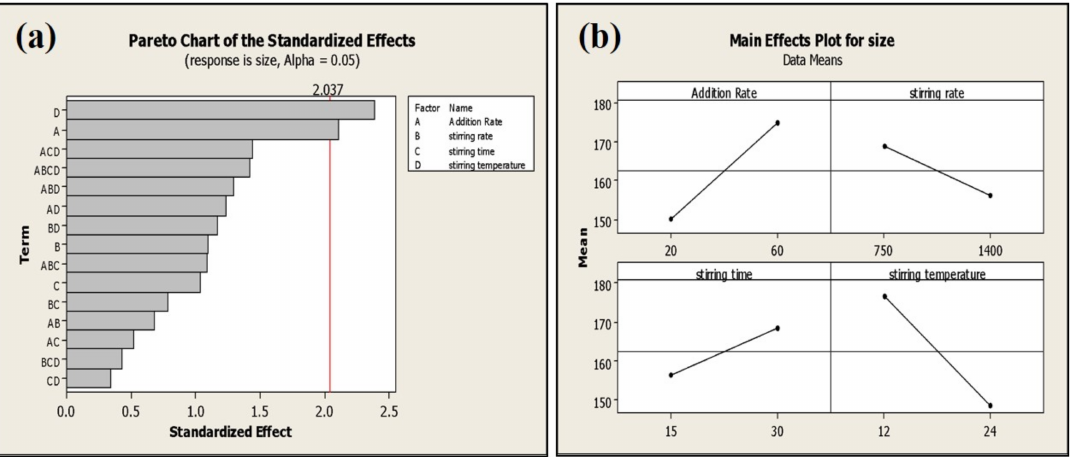
Figure 6. Pareto ( a ) and main e ff ect plot ( b ) of process parameters (PP) on average particle size. Stirring temperature perspective batches processed at high temperatures exhibited low average particle size compared to batches processed at low temperatures (Table 1). Moreover, stirring temperature is the most significant factor affecting EGCG loading on phospholipid ( p ≤ 0.001). Phytosomal batch